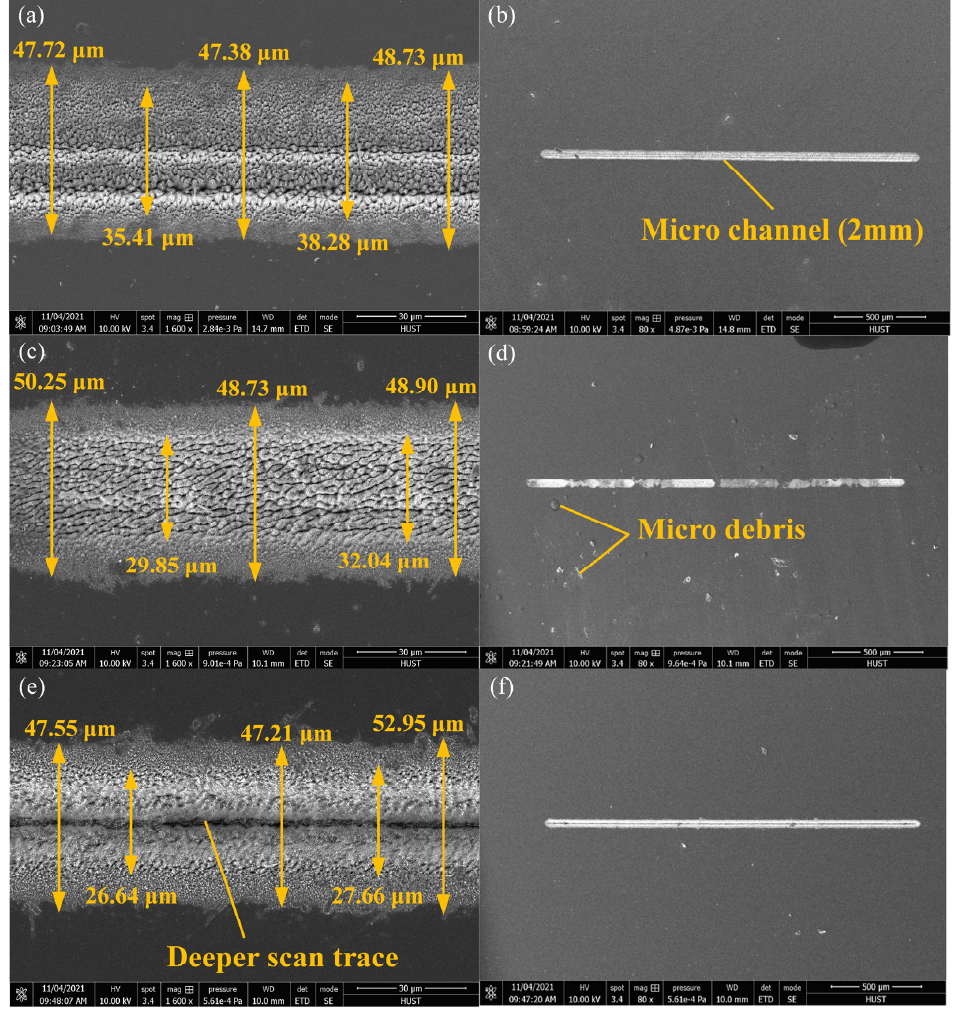
Figure 9. Profiles and morphology of micro channels under different liquid mediums: ( a , b ) deionized water; ( c , d ) 5.6 mol/L phosphoric acid solution; ( e , f ) absolute ethyl alcohol.